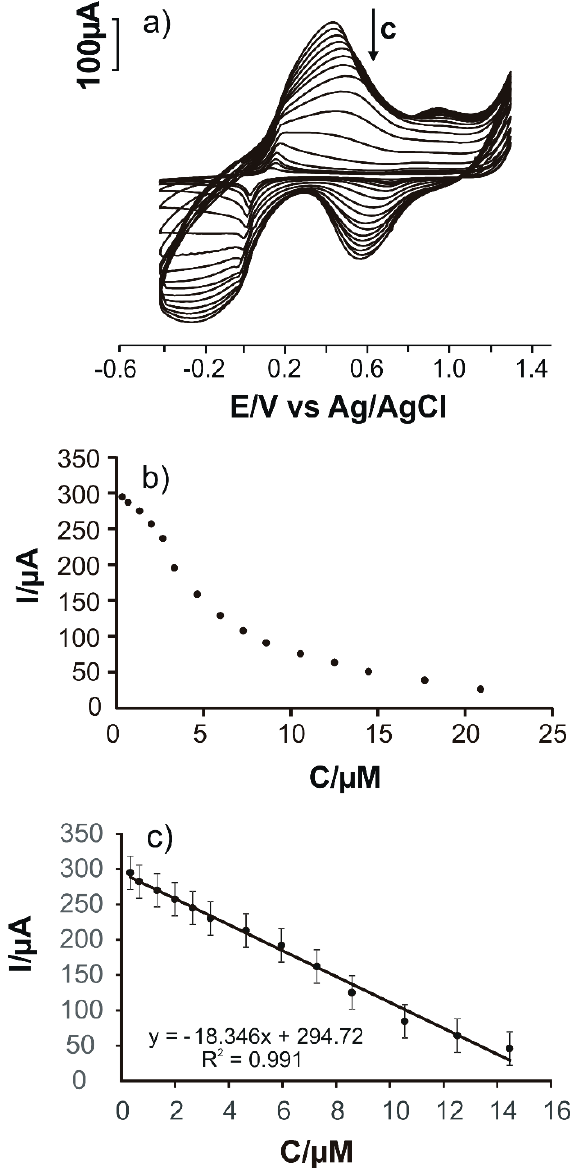
Figure 5. ( a ) Cyclic voltammograms of PB-SPCE immersed in Phe solutions in the range 0.33–21 µM. ( b ) Dependence between I pa and Phe concentration in the range 0.33–21 µM. ( c ) Linear dependence between I pa and Phe concentration in the range 0.33–14.5 µM.